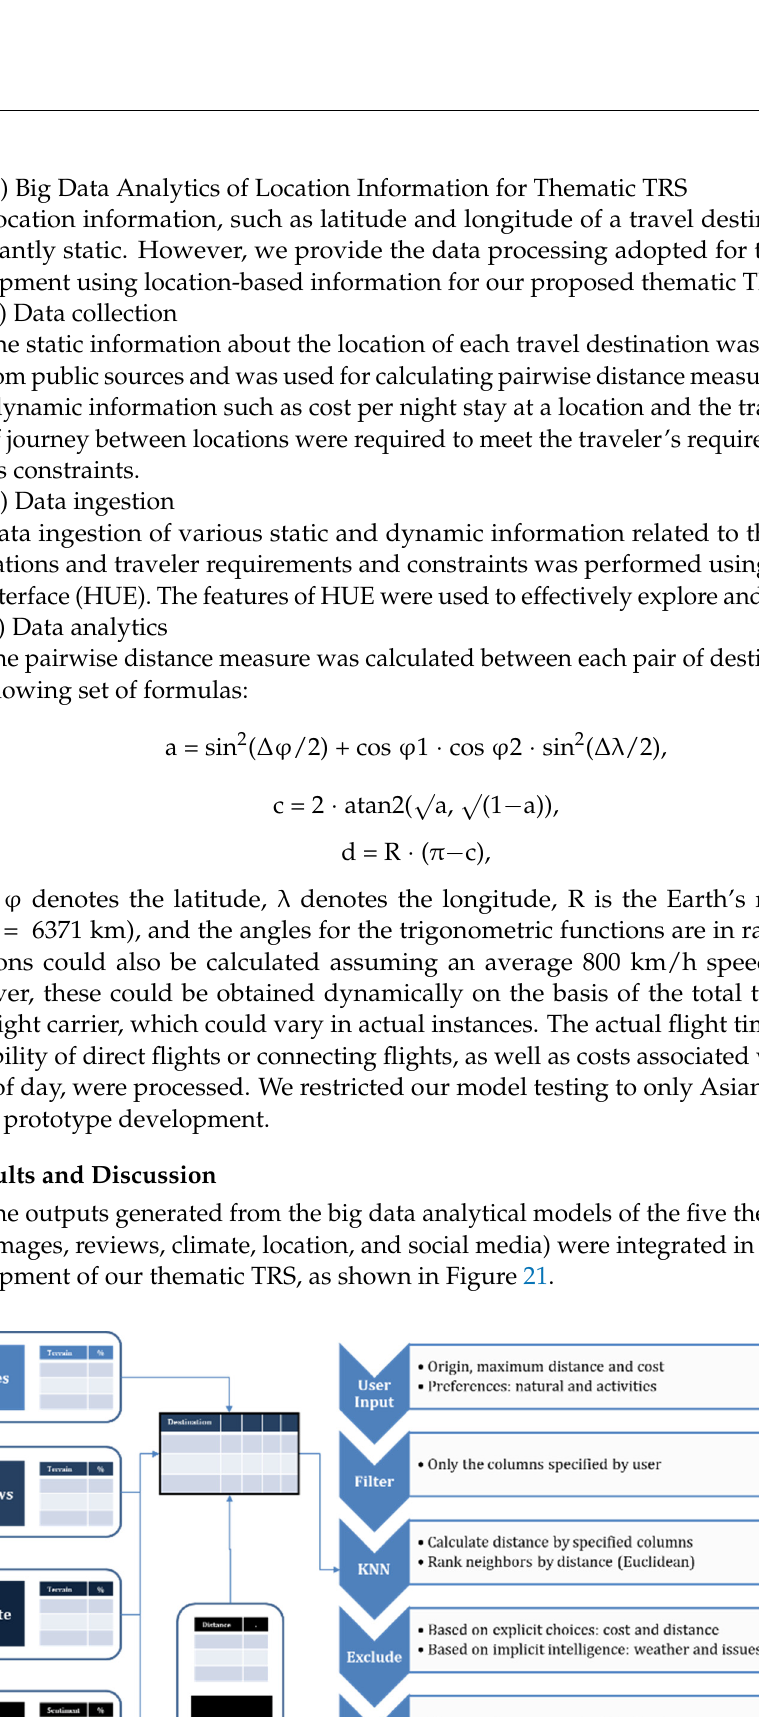
Figure 20. Twitter messages sored in HDFS using HUE with Hive scripts.